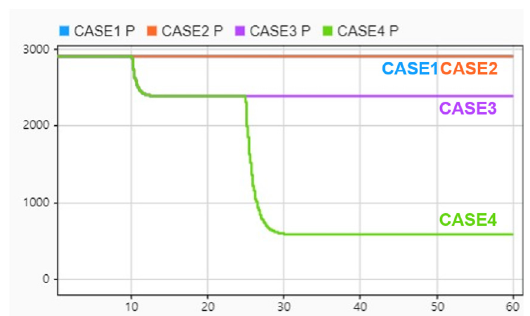
Figure 16. Active power output of the G1 Inverter.